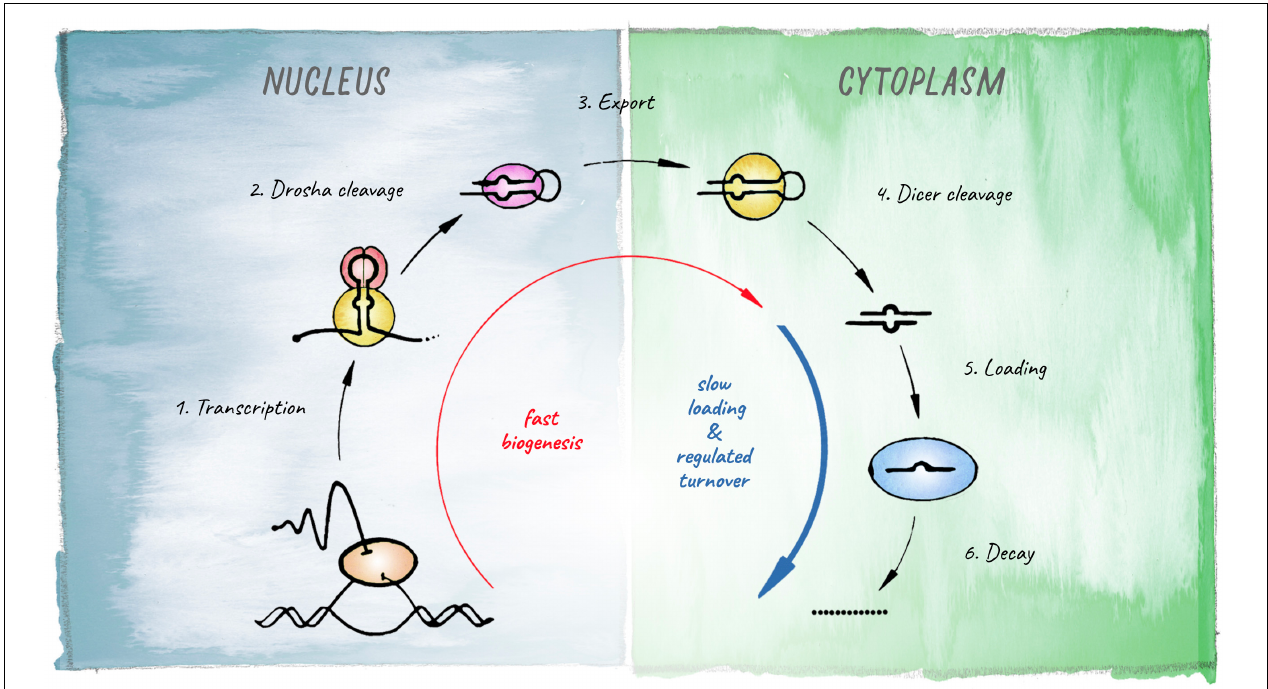
FIGURE 2 | Schematic of the miRNA biogenesis pathway. The different steps leading to production of a mature miRNA are shown. Kinetic studies in Drosophila revealed that biogenesis is fast for most miRNAs but loading into Argonaute represents the rate-limiting step (based on Reichholf et al., 2019).